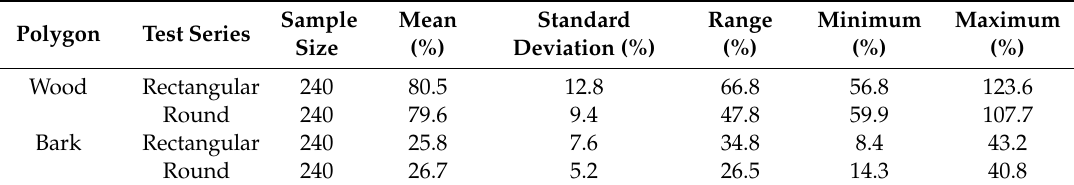
Table 2. Descriptive statistics of the main results comparing the single debarking percentage measurement values.